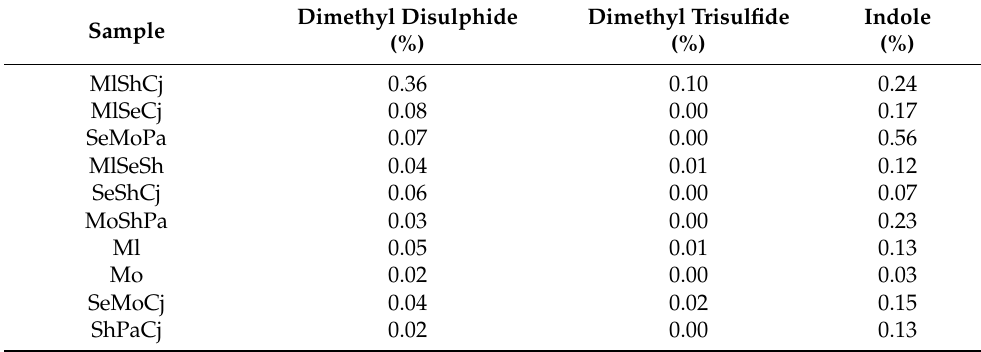
Table 6. Concentrations of dimethyl disulfide, dimethyl trisulfide, and indole in the measured